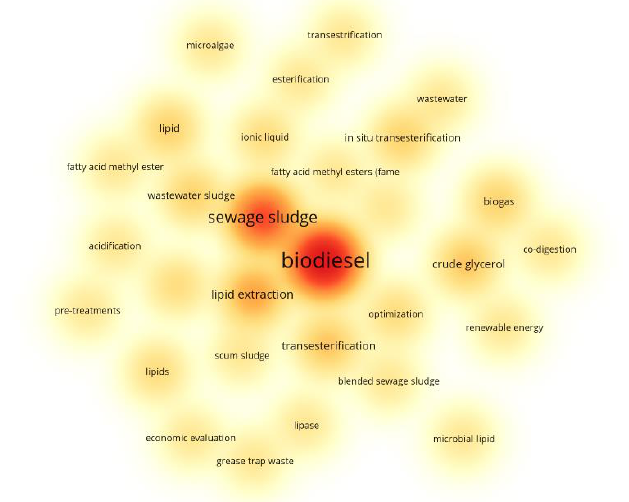
Figure 12. Density map of the database keywords relating to biodiesel production from sewage sludge. More intense color points indicate a higher number of keyword occurrences.